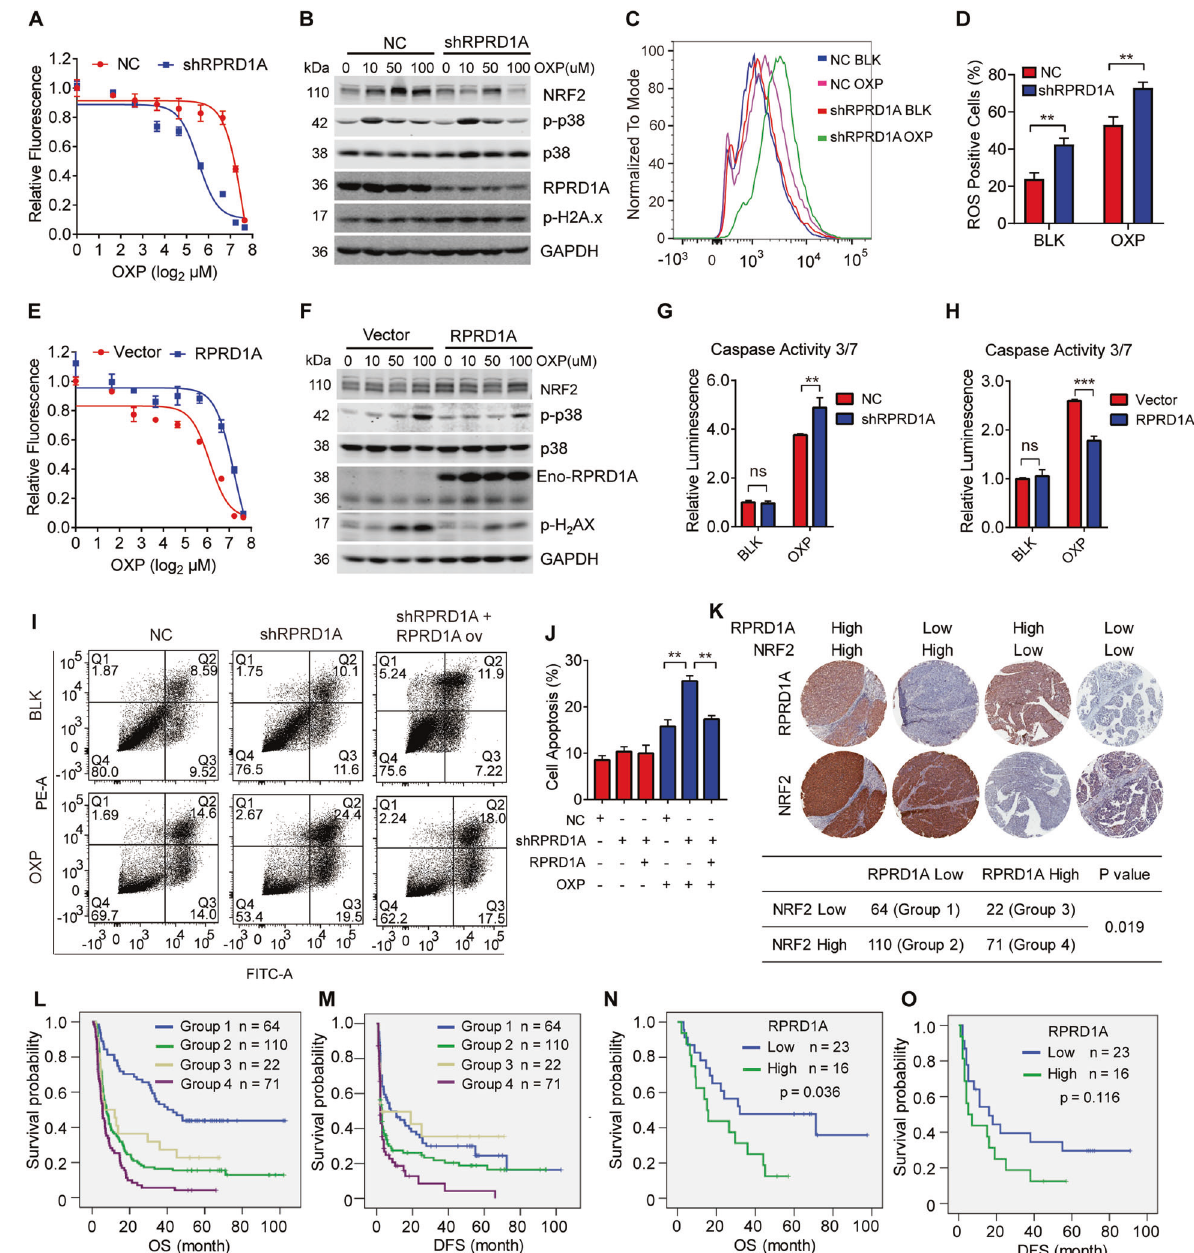
Fig. 6 RPRD1A induced ROS inhibition correlates with chemotherapeutic resistance. A Cell survival of MHCCLM3 NC and shRPRD1A cells exposed to serial dilutions of OXP for 60 h. B Western blot of lysates generated from MHCCLM3-NC and -shRPRD1A cells treated with OXP as indicated. C ROS levels were detected by fl ow cytometry in MHCCLM3 NC and shRPRD1A cells treated with 50 μ M OXP or control for 4 h. D Quanti fi cation of the ROS levels in ( C ). E Cell survival of control and MHCCLM3-RPRD1A cells exposed to serial dilutions of oxaliplatin for 60 h. F Western blotting of lysates generated from control and MHCCLM3-RPRD1A cells treated with OXP as indicated. G , H Caspase 3/7 assay was performed to detect the activity apoptosis of MHCCLM3-NC and MHCCLM3-shRPRD1A ( G ), control and MHCCLM3-RPRD1A ( H ) treated with 50 μ M OXP for 24 h. I Annexin V and PI staining analysis were performed to test cell apoptosis of MHCCLM3-NC, MHCCLM3-shRPRD1A and RPRD1A supplemental cells treated with or without 100 μ M OXP for 6 h. J Histogram was the quanti fi cation. K Representative images of RPRD1A and NRF2 staining in HCC specimens. Group 1, low NRF2 and low RPRD1A expression ( n = 64); group 2, high NRF2 and low RPRD1A expression ( n = 110); group 3, low NRF2 and high RPRD1A expression ( n = 22); and group 4, high NRF2 and high RPRD1A expression ( n = 71). The cross table showed the distribution of RPRD1A and NRF2 expression in HCC samples ( n = 267); the Pearson λ 2 correlation coef fi cient and p value are shown. L , M Kaplan – Meier analysis of OS ( L ) and DFS ( M ) in HCC patients according to RPRD1A and NRF2 expression. N , O Kaplan – Meier analysis of OS ( N ) and DFS ( O ) in HCC patients with TACE according to RPRD1A expression. In panels ( D ), ( H ), ( J ), the p values were determined by a two-tailed t-test. In panels L – O , the p values were determined by the log-rank test. * p < 0.05, ** p < 0.01, *** p < 0.001. Results are representative of at least three independent